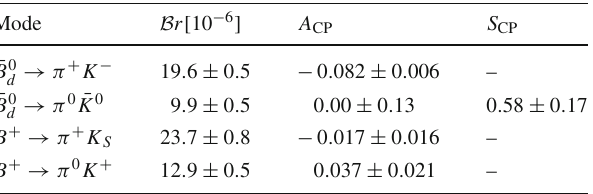
Table2 Overviewofthecurrentmeasurementsinthe B → π K system